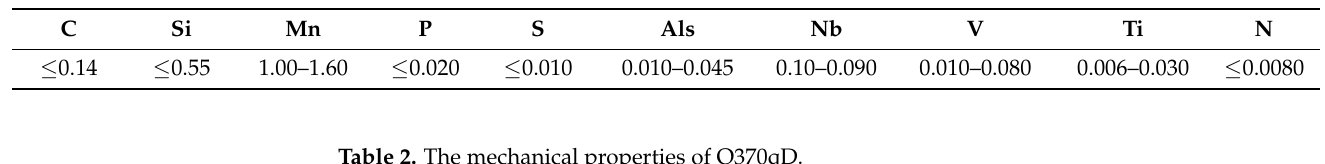
Table 1. The chemical composition of Q370qD (%) [39].